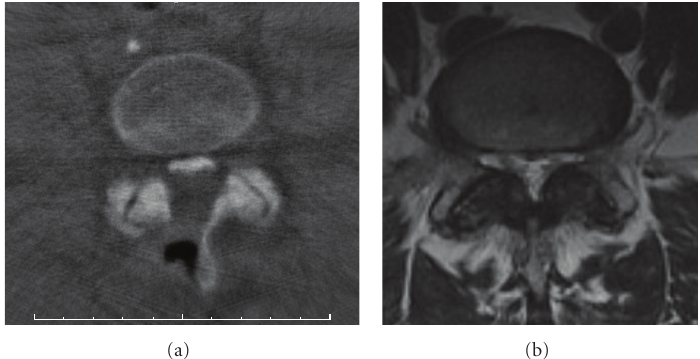
Figure 1: (a) Axial reconstruction demonstrating decompression from the left side with su ffi cient decompression on the right side. (b) Preoperative MR image of the same patient as in (a).